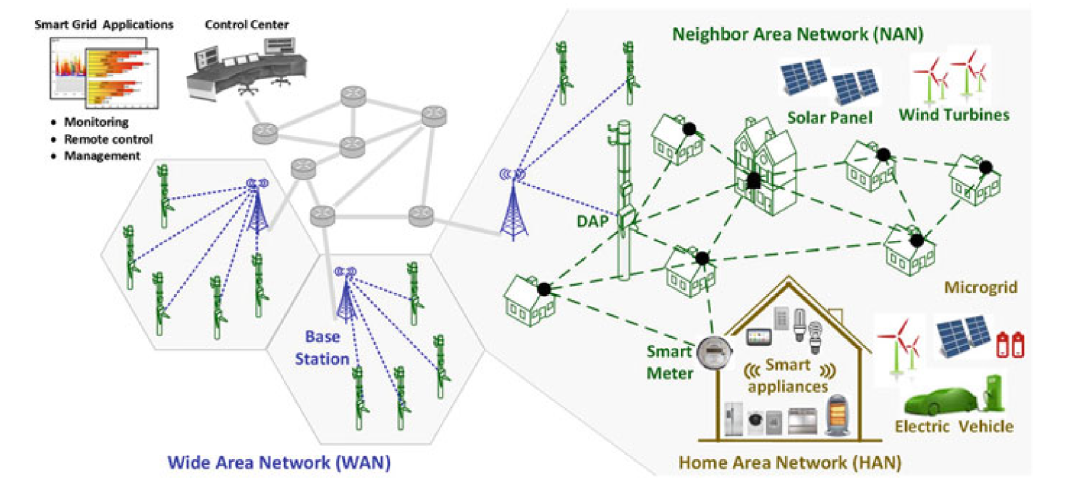
Figure 1. Smart Grid Communication Network